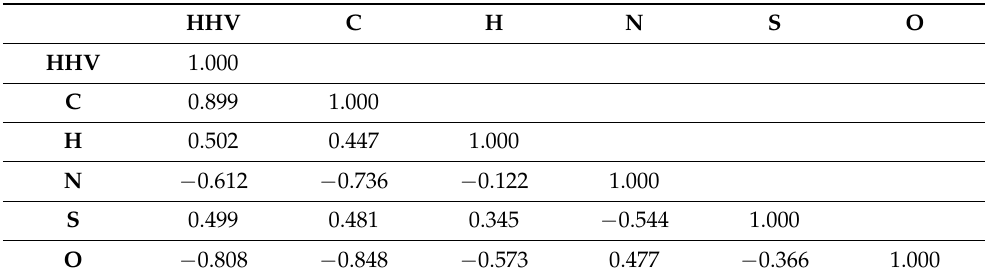
Table 7. Pearson’s test for experimental results from the ultimate